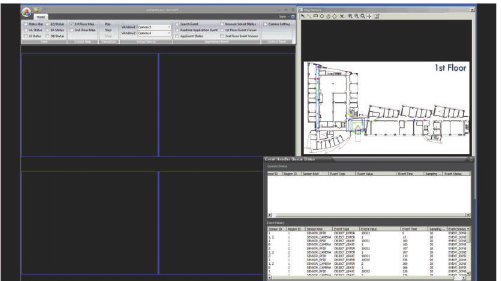
Figure 13: Illustration of modeling the execution behaviors where user codes are additionally defined for the realistic application